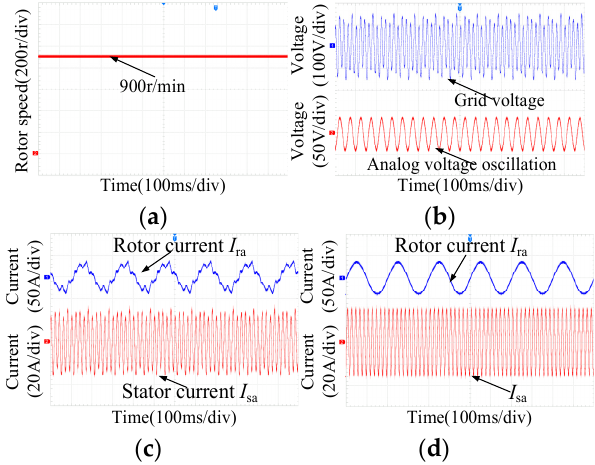
Figure 17. The oscillation suppression suppressed-contrast waveforms at SSO frequency of 30 Hz: ( a ) DFIG rotor speed; ( b ) grid voltage oscillation waveform; ( c ) before oscillation suppression; ( d ) after oscillation suppression.